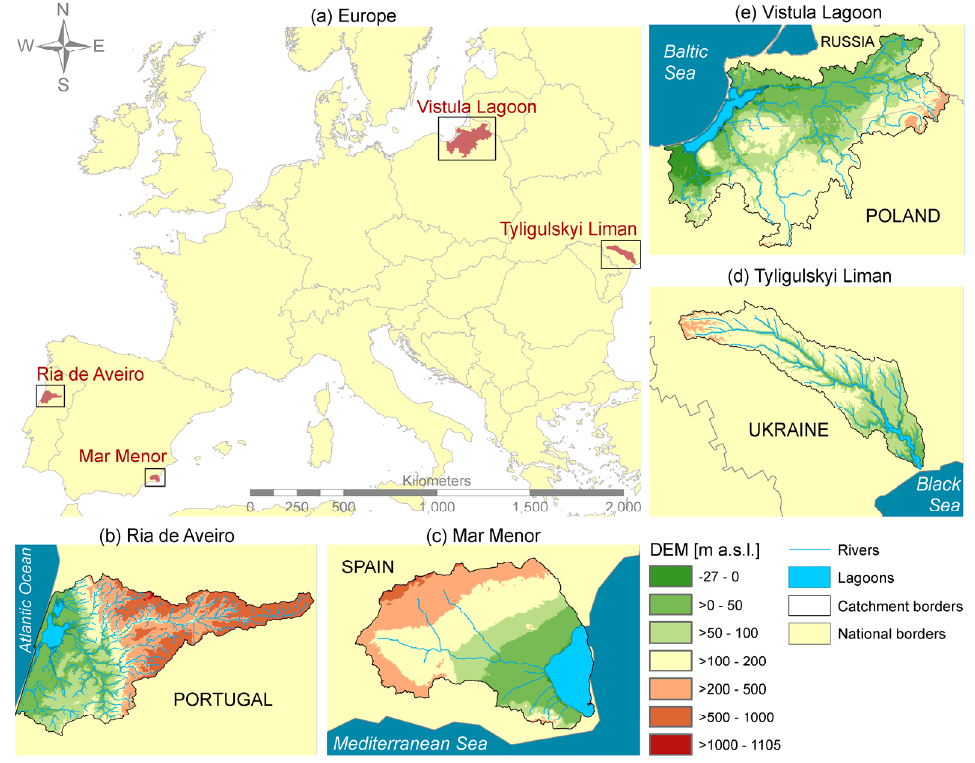
Figure 1. Location of the four case study areas (CSAs) within Europe ( a ) as well as the Digital Elevation Models (DEM), locations of lagoons, and main inflowing rivers per CSA ( b – e